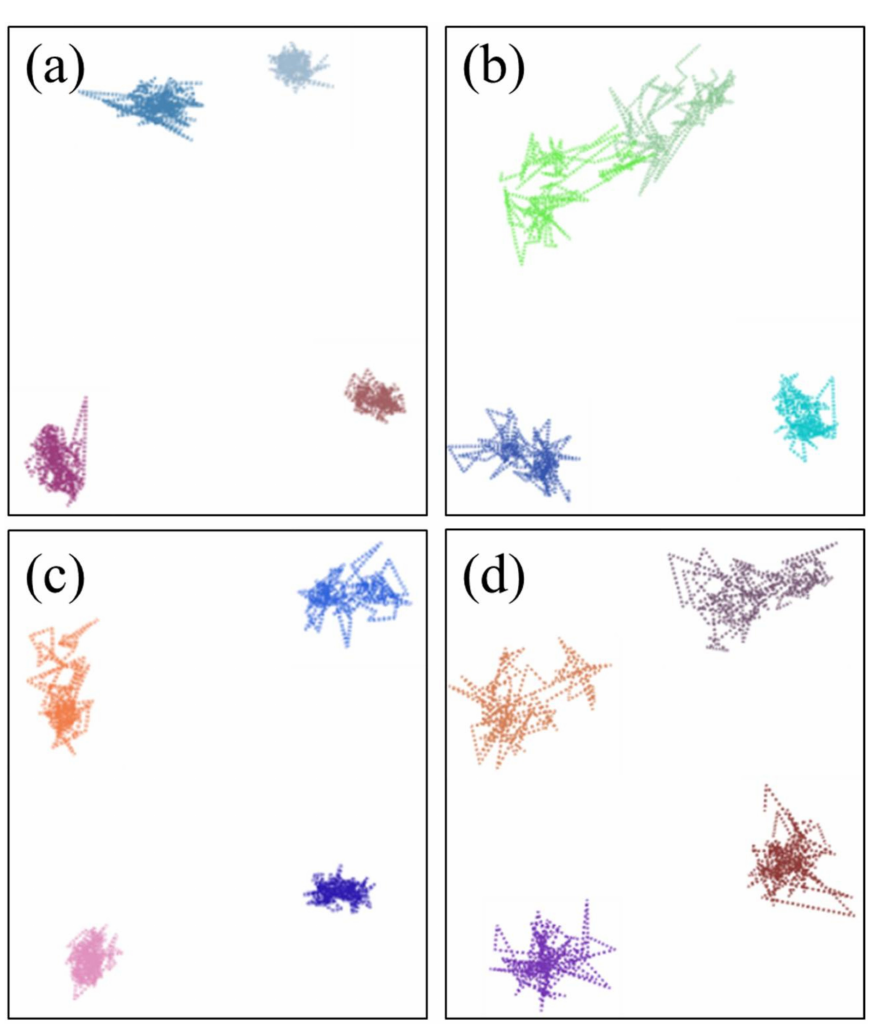
Figure 15. The motion trajectories of the cyclohexane molecules in the aged NBR models: ( a ) 298.15 K/OH-NBR; ( b ) 383.15 K/OH-NBR; ( c ) 298.15 K/CO-NBR; ( d ) 383.15